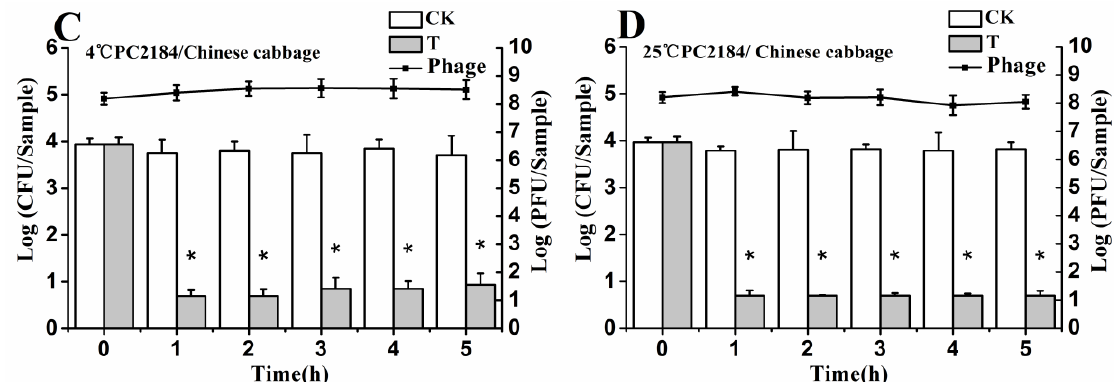
Figure 6. Effects of individual phages on growth of SE ATCC13076 and CVCC2184 on the surface of Chinese cabbage samples at 4 °C and 25 °C. Each sample was inoculated with either SE ATCC13076 ( A , B ) or SE CVCC2184 ( C , D ) (1 × 10 4 CFU), and phage PA13076 or PC2184 was applied (1 × 10 8 PFU) later (CK, inoculated control without phage; T, treated with phage). The titers of phage were also detected each sampling time (indicated in a dotted line). Date represent the mean ± S.D. ( n = 3), * represents p < 0.05 (Duncan’s test).